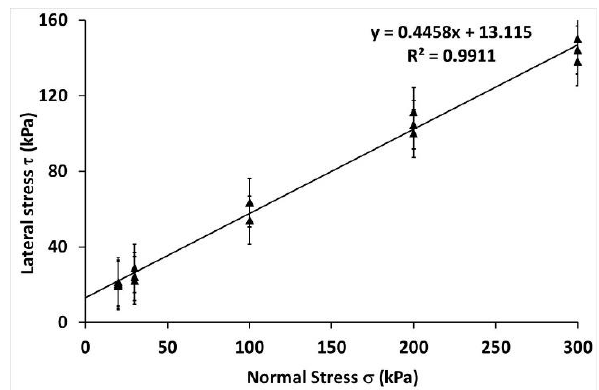
Figure 7. Regression line for the Mohr – Coulomb strength envelope for wheat obtained from direct shear assays.